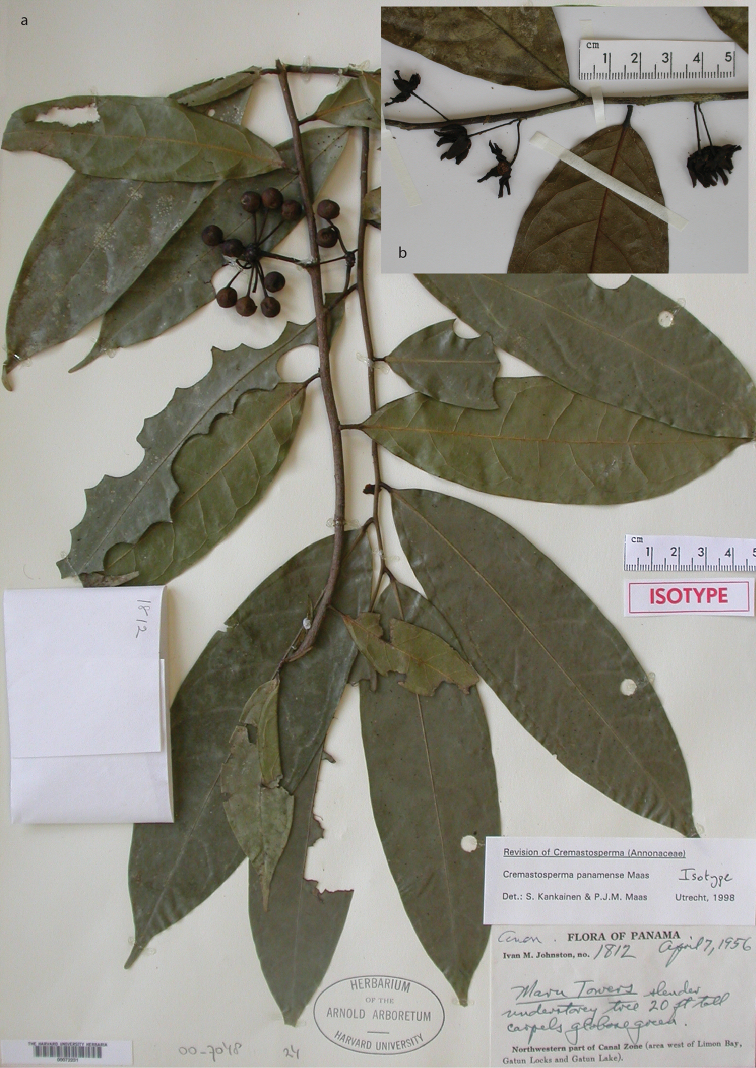
Cremastospermapanamense Maas. a fruiting specimen b flowers (aJohnston 1812bPerez 832).